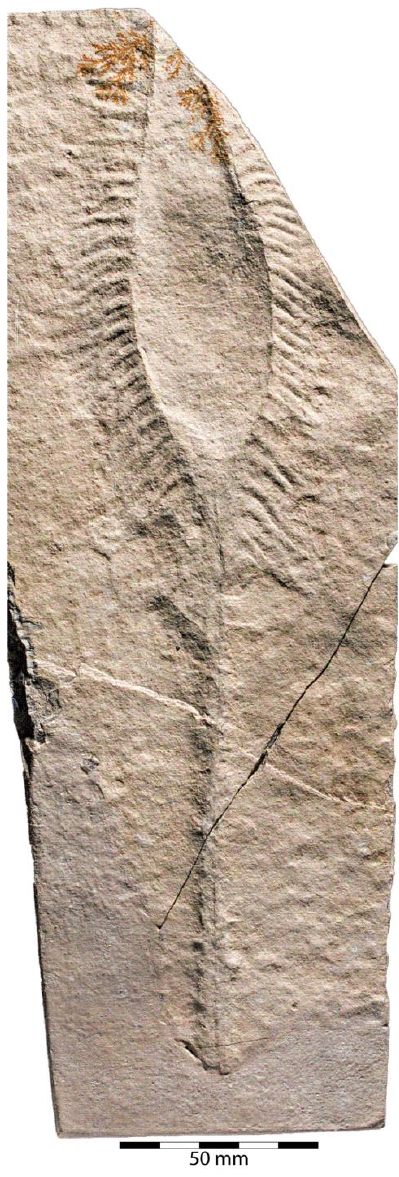
Figure 9. † Chimaerotheca schernfeldensis Duffin et al., 2021 [99], also see [131] (NHMUK PV Z.183) egg capsule morphotypes from the Solnhofen Archipelago.